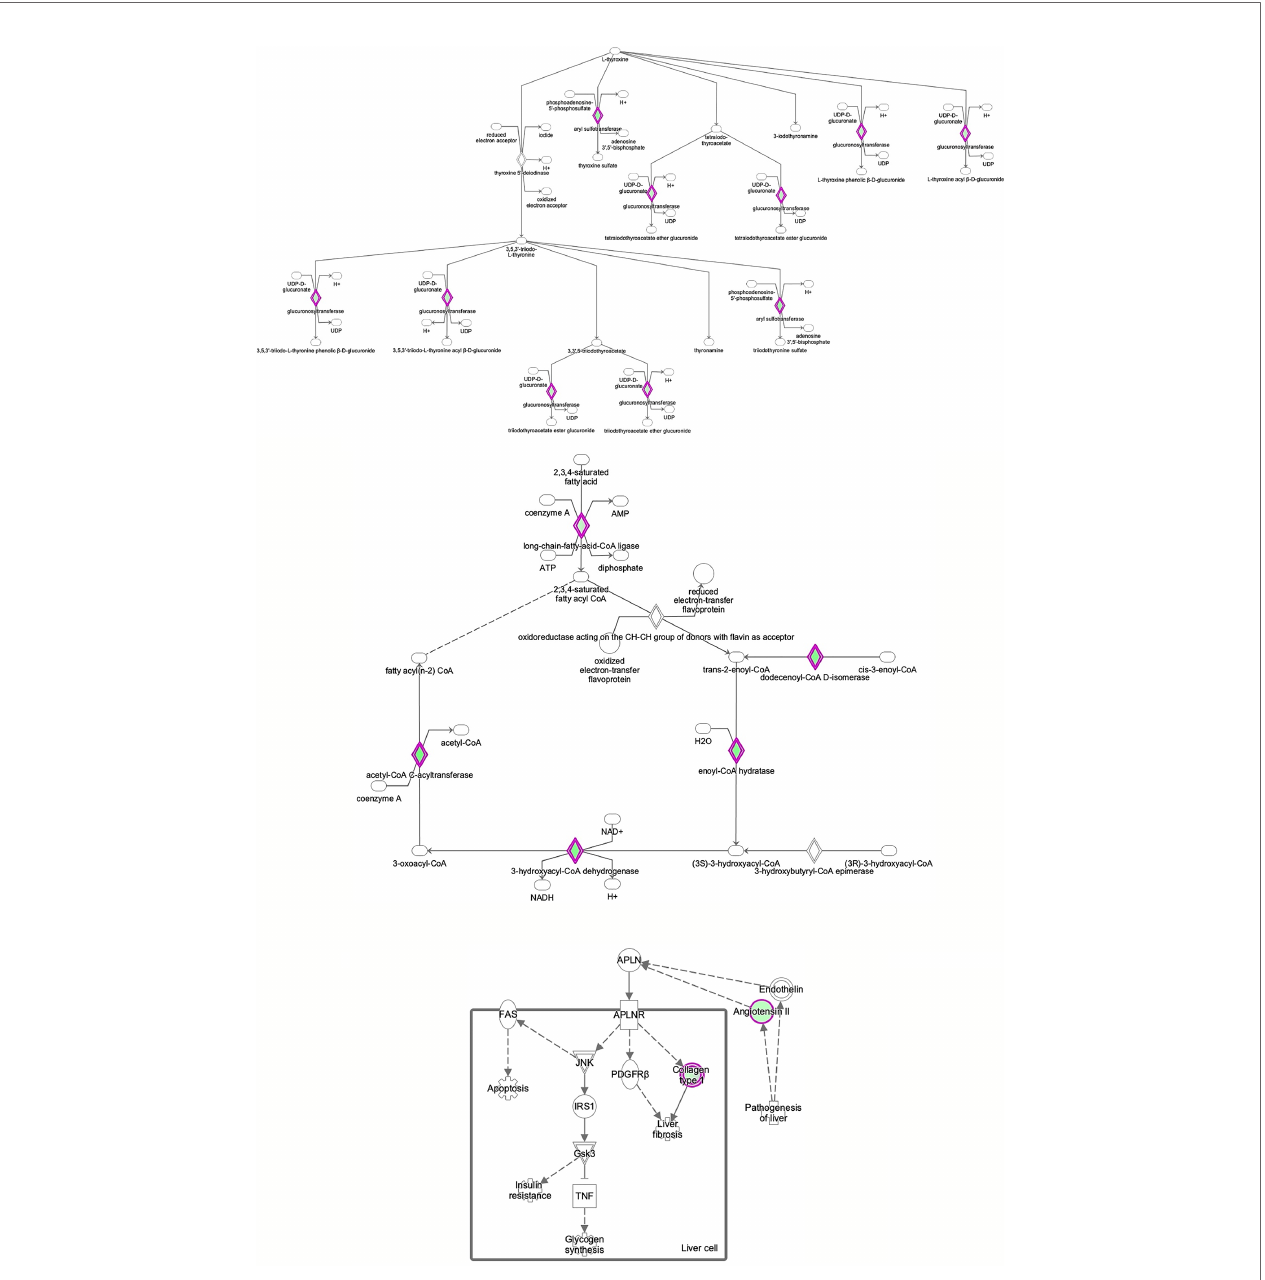
FIGURE 8 | Ingenuity Pathway Analysis of differentially expressed proteins in non-FGR compared to control group showed inhibition of thyroid hormone metabolism (z= − 2.0, p = 2.5e-2) , fatty acid beta oxidation (z = − 2.0, p = 1.6e-2) and apelin liver signaling pathway (z = − 2.0, p = 6.7e-3) . Apelin inhibits liver regeneration while promoting hepatic fi brosis upon injury. It also has an anti-insulin resistance